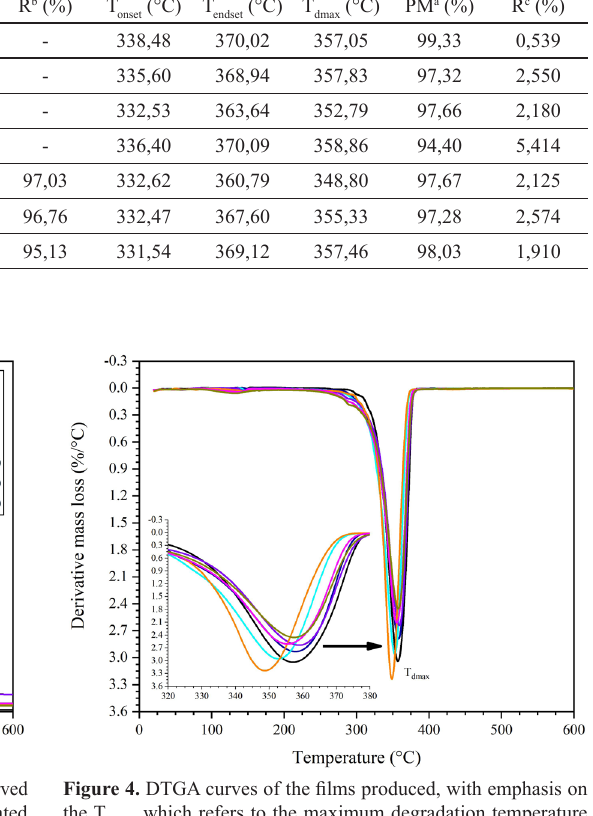
Table 3. Thermal parameters obtained by TGA and DTGA. 1st thermal event 2nd thermal event Systems